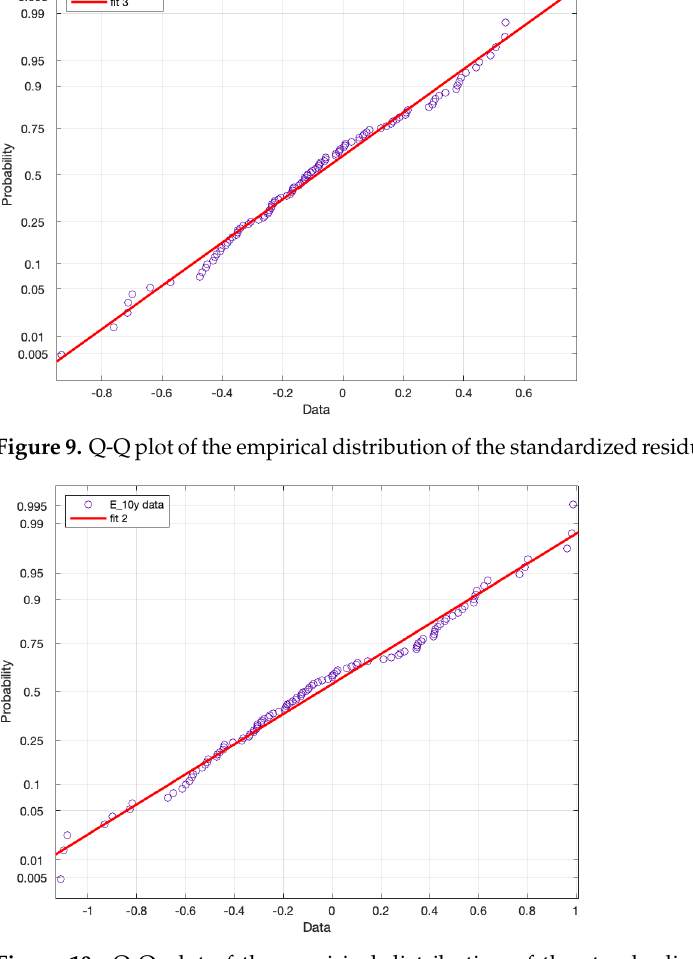
Figure 10. Q-Q plot of the empirical distribution of the standardized residuals for the 10-year bond